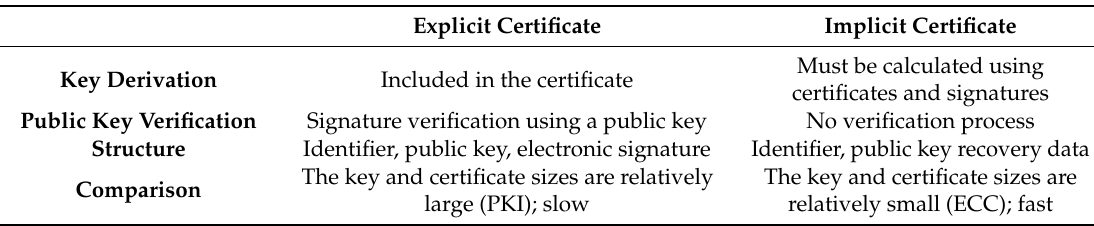
Table 1. A comparison of explicit and implicit certificate. PKI, public key infrastructure; ECC, elliptic curve